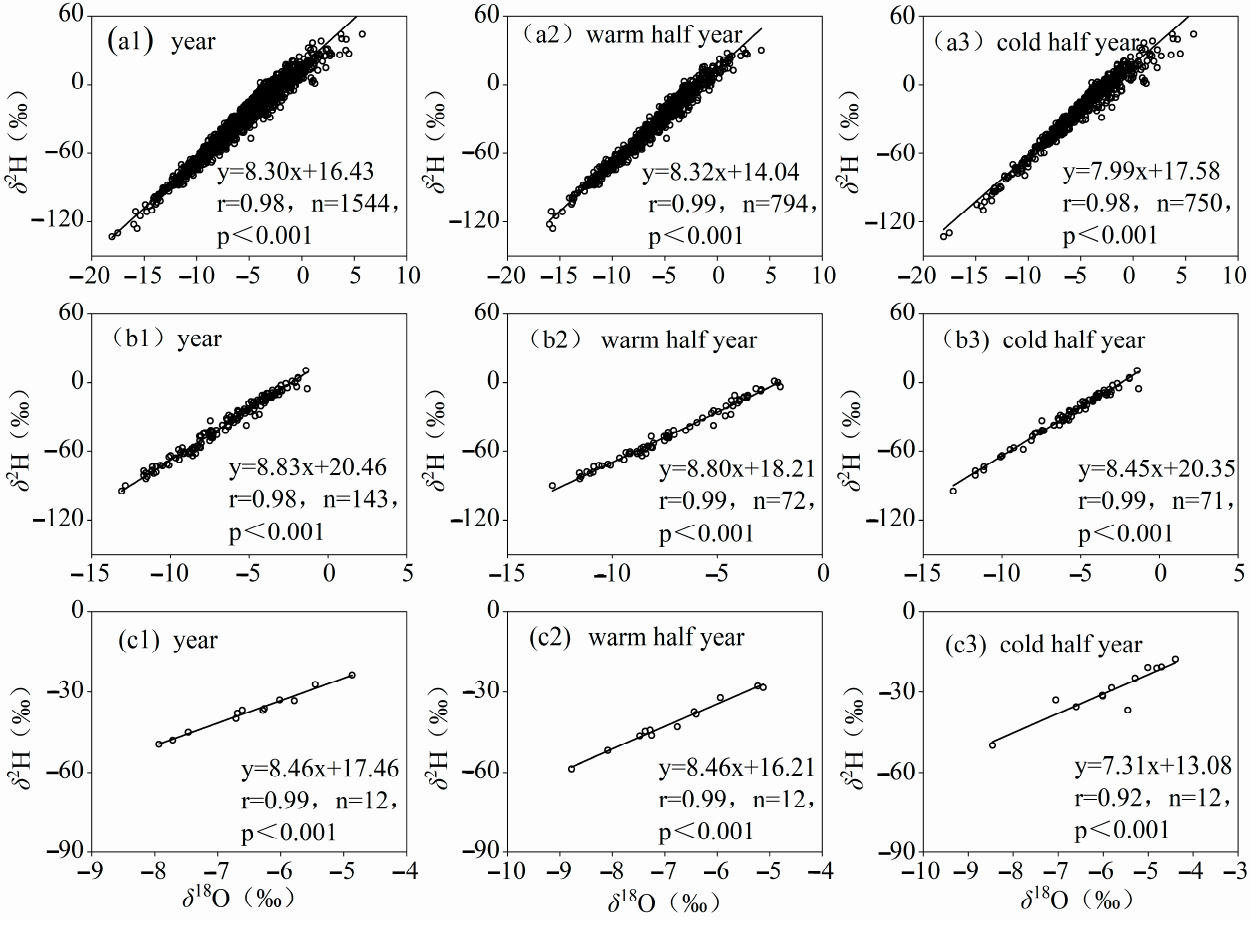
Figure 6. Variations in LMWLs on daily ( a1 , a2 , a3 ), monthly ( b1 , b2 , b3 ) and annual ( c1 , c2 , c3 ) time scales in three periods: entire year ( a1 , b1 , c1 ), warm half of the year ( a2 , b2 , c2 ) and cold half of the year ( a3 , b3 , c3 ) in Changsha. Table 2. Variations in the local meteoric water lines (LMWLs) with precipitation intensities on daily and monthly time scales in Changsha